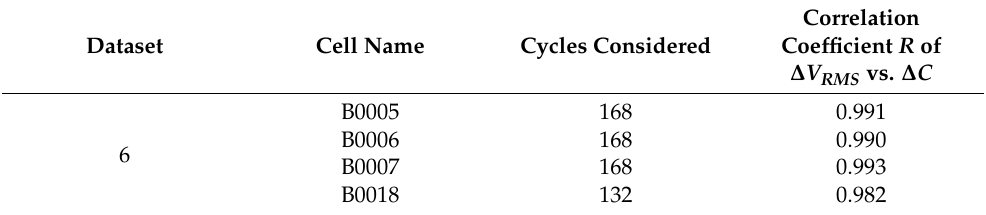
Table 2. Parameters of the analyzed cells when discharged at a C-rate of